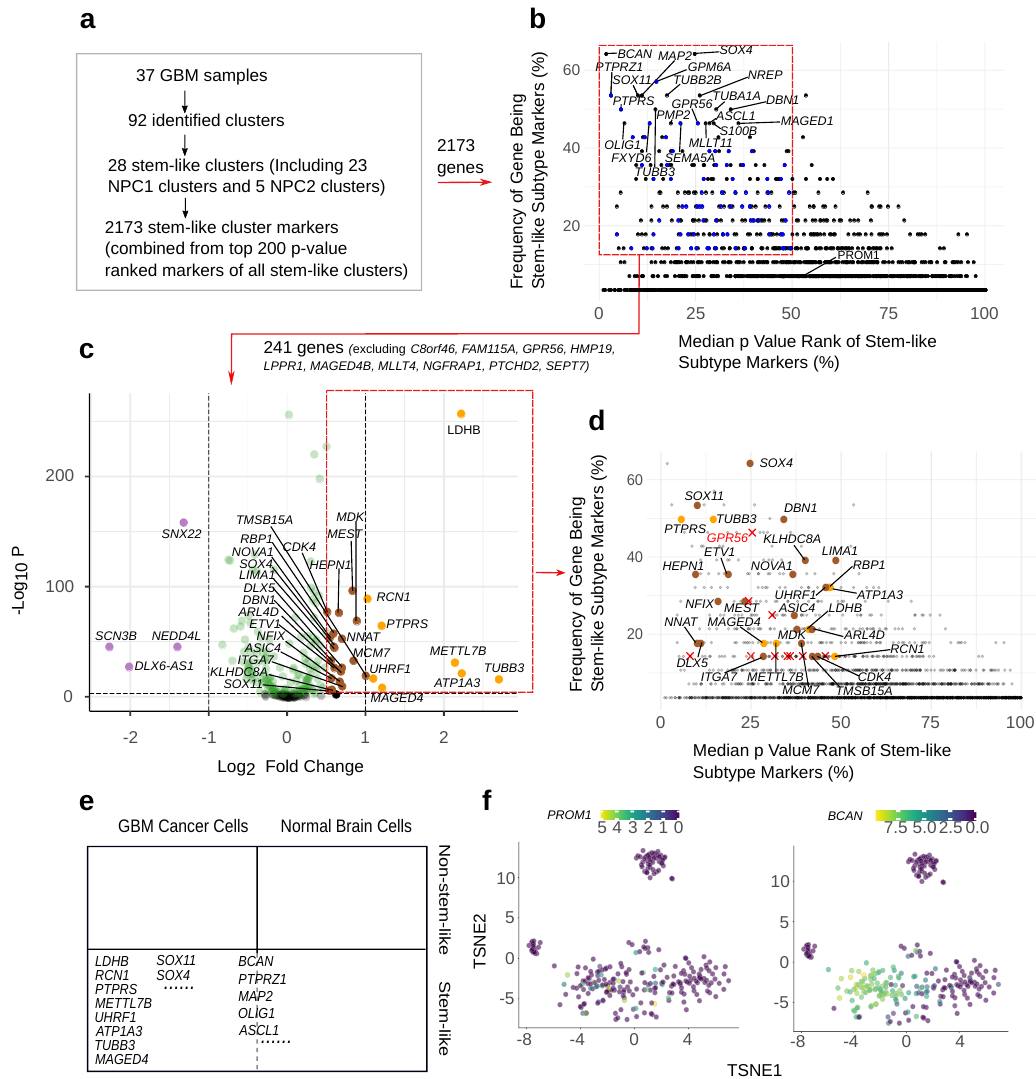
Figure 2. The procedure for the selection of stem-like markers of GBM that excel in both identifying stem-like subtypes within the tumor and being cancer-specific. ( a ) The process of selecting GBM stem- like subtype marker candidates. ( b ) The stem-like subtype marker candidates were evaluated based on their frequency of being a stem-like cluster marker and the corresponding significance shown by the median p -value across the represented clusters. The dots represent the 2173 unique stem-like marker candidates combined from the top 200 marker genes of the 28 stem-like clusters. ( c ) The expression level comparison between normal brain cells and GBM stem-like cells of 241 markers from the previous frequency–significance selection. The criteria for the orange genes are logFC > 1 and p -value < 0.01, and the criteria for the brown genes are 0.5 < logFC < 1 and p -value < 0.01. Both colors were considered significant in the comparison. ( d ) The genes selected to distinguish normal brain cells from GBM stem-like cells marked on the frequency–significance selection shown in Figure